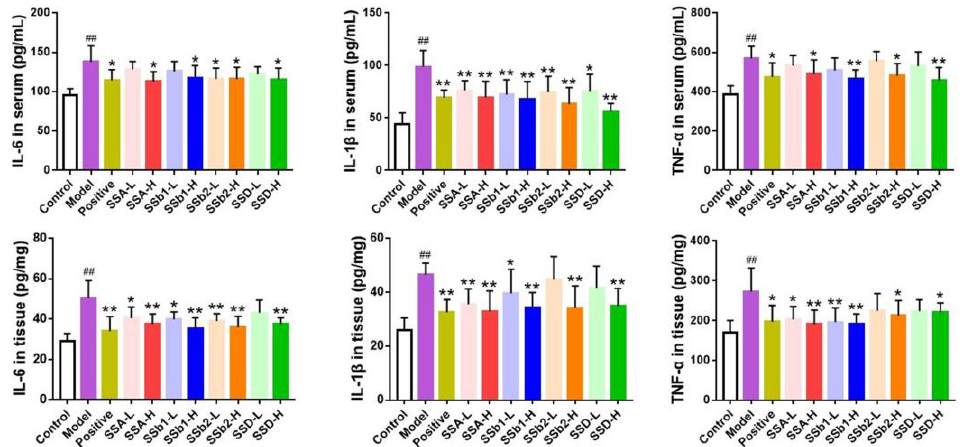
Figure 5. Effects of SSA, SSb1, SSb2, and SSD on the levels of IL-6, IL- 1β , and TNF- α in serum and lung tissues from LPS-induced ALI mice ( n = 8, means ± SD s). Analyzed using a one-way ANOVA. ## p < 0.01 vs. control group; * p < 0.05, ** p < 0.01 vs. LPS-induced model group.